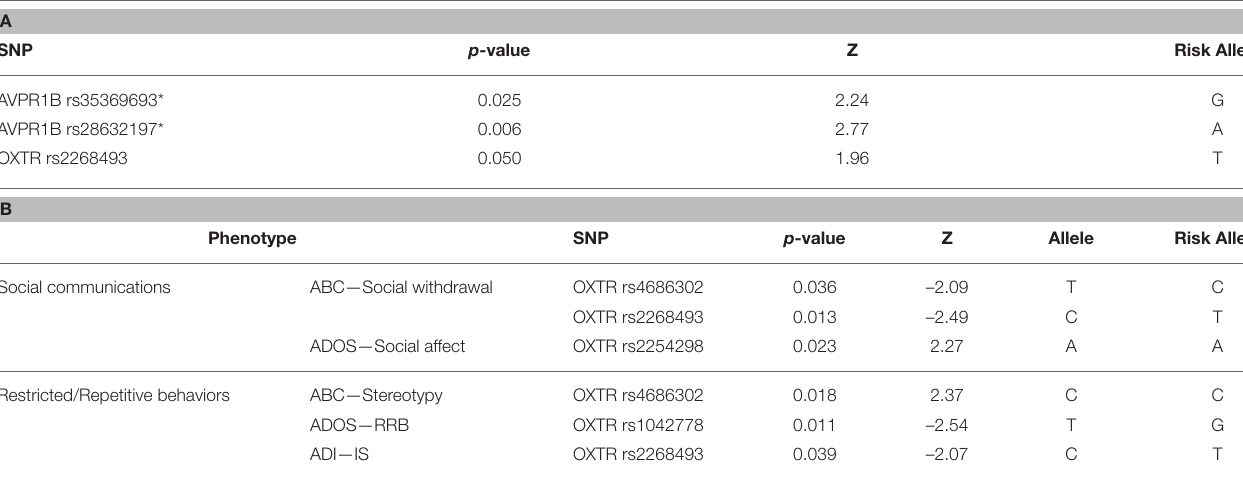
TABLE 2 | Significant SNP